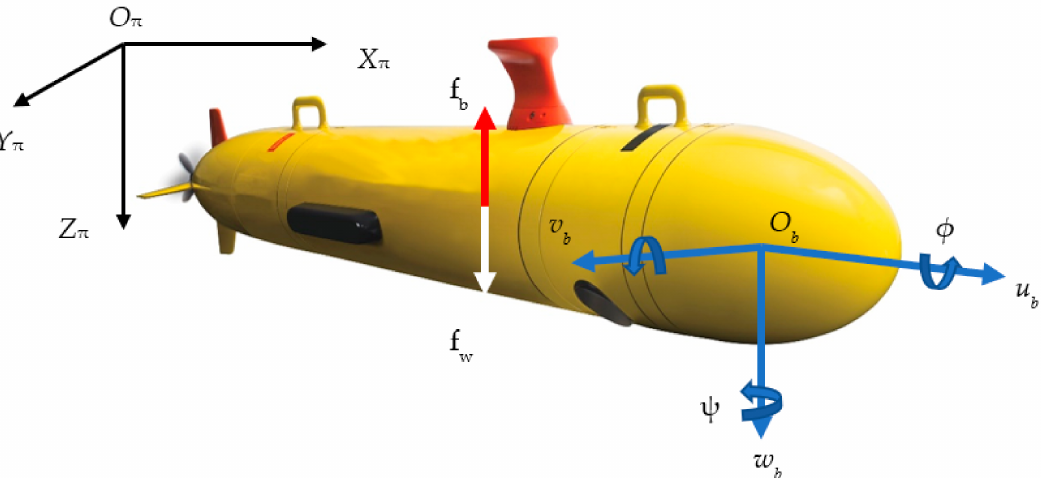
Figure 4. Coordinate frames in